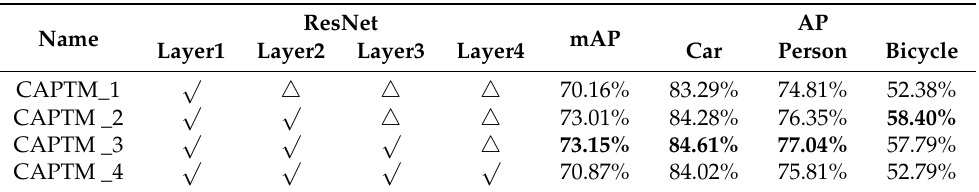
Table 4. The results of the CAPTM module after temperature information was inserted into different √ layers. Note: indicates the use of the CAPTM module, (cid:52) indicates the use of the CBAM module, and CAPTM_x indicates the use of the CAPTM module for the first x layers in ResNet.